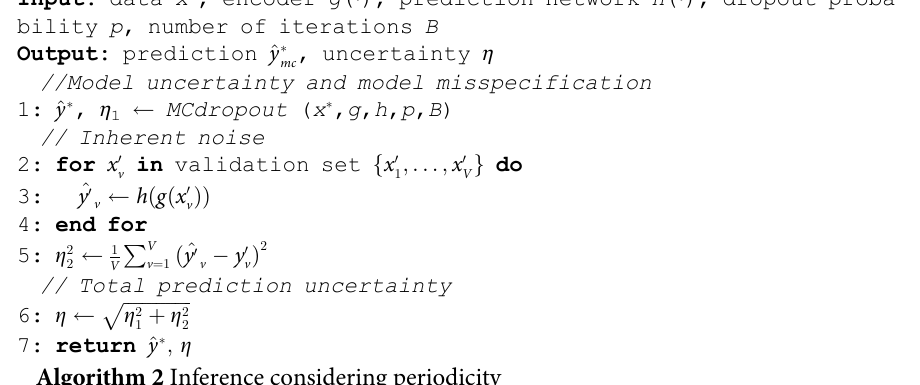
Algorithm 2 Inference considering